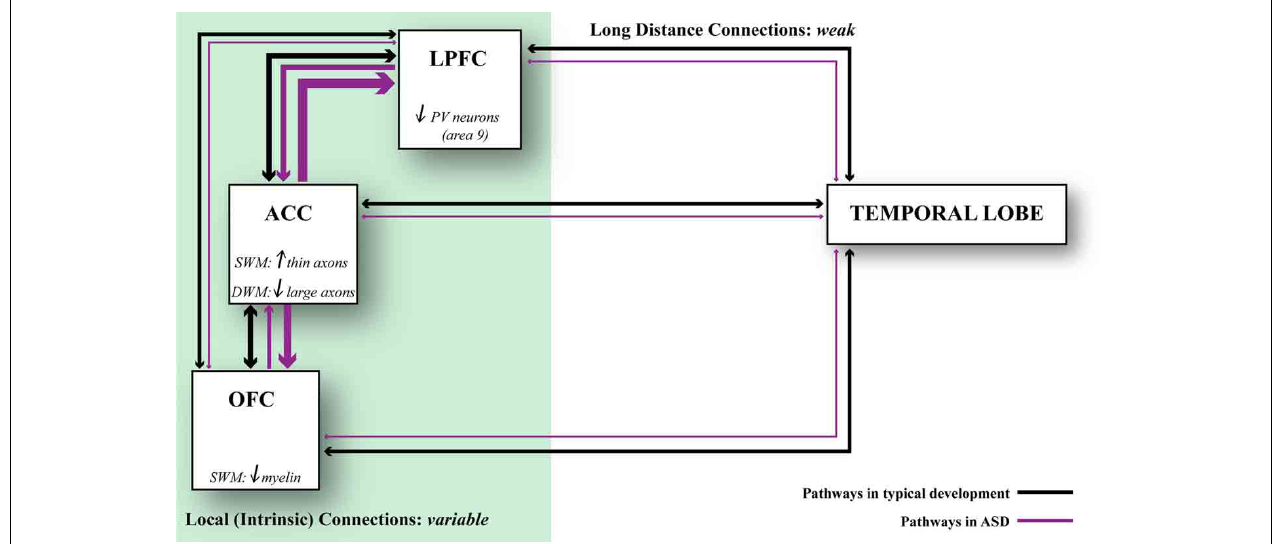
FIGURE 5 | Relationship of axonal features to developmental events. Changes in axons and inhibitory neurotransmission affect network dynamics in ASD. ACC exhibits local overconnectivity in ASD, which combined with changes in the ratio of inhibitory neurons in LPFC can tip the balance of excitation and inhibition. OFC exhibits weak local connectivity in ASD due to